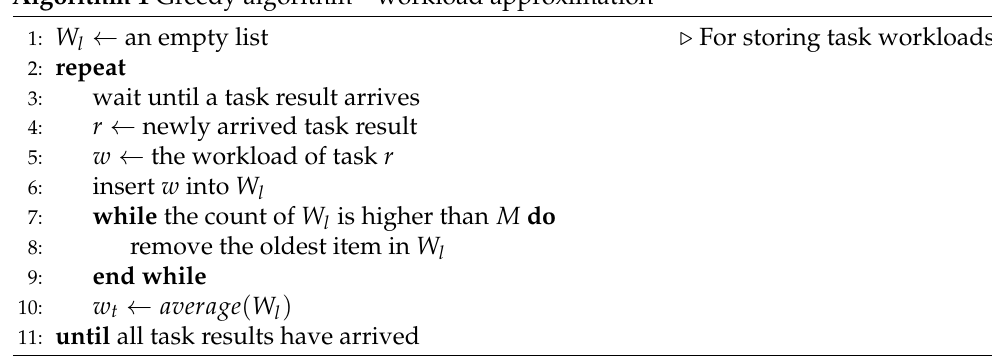
Algorithm 1 Greedy algorithm—workload